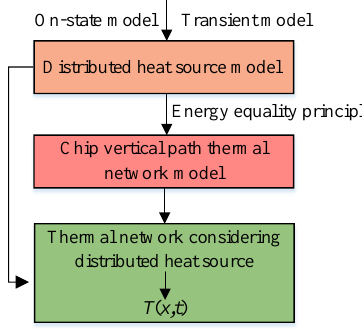
Figure 1. Model structure.